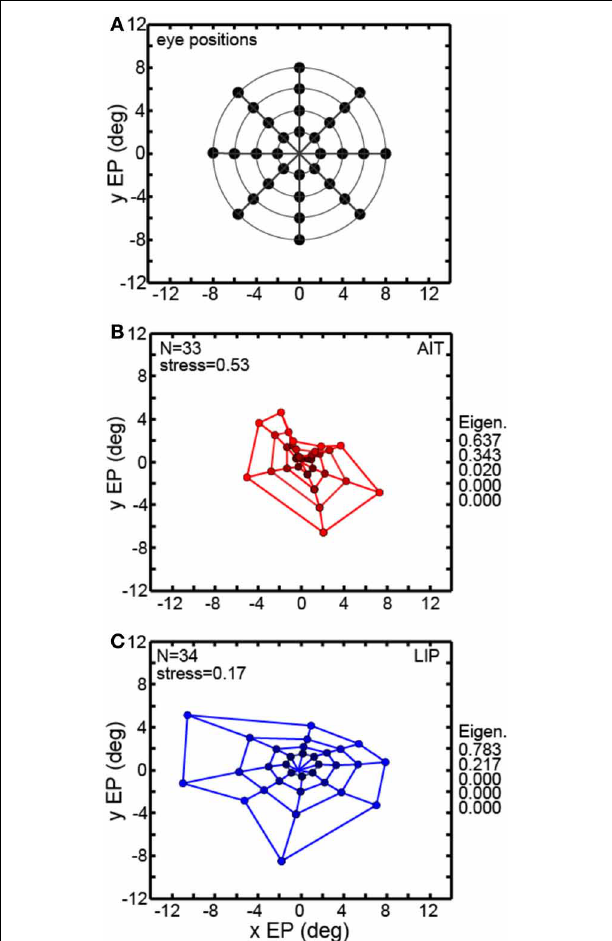
FIGURE 3 | Recovery of eye positions from neural population activity, using a global stimulus configuration and multidimensional scaling (MDS) analysis. MDS analysis was based on using interpolated neural responses from recorded neurons that had significant spatial selectivity under ANOVA. This analysis used mean neural response across trials. (A) Set of eye positions used as input configuration for MDS analysis. It consisted of 32 points arranged in a polar grid. The center of the grid corresponded to central fixation. As illustrated, the eye positions were arranged over four eccentricities with visual angles of [2 ◦ , 4 ◦ , 6 ◦ , 8 ◦ ]. At each eccentricity, eight locations were arranged in an iso-centric circle at 45 ◦ polar angle increments. Each of the 32 eye positions produced a different activation pattern (response vector) in the population of neurons in our data set. Lines connecting the positions merely help illustrate iso-eccentricity positions and iso-polar angles as well as highlight the overall symmetry of the spatial configuration. (B) Configuration of eye positions recovered from AIT data, shown in red. (C) Configuration of eye positions recovered from LIP data, shown in blue. There is less distortion apparent in the spatial layout of the LIP grid compared to AIT and the LIP stress value is lower than in AIT, indicating a more accurate global recovery of eye positions. For both panels (A) and (B) , color darkens with decreasing eccentricity, to aid visualization. Also for both panels, normalized MDS eigenvalues are displayed.